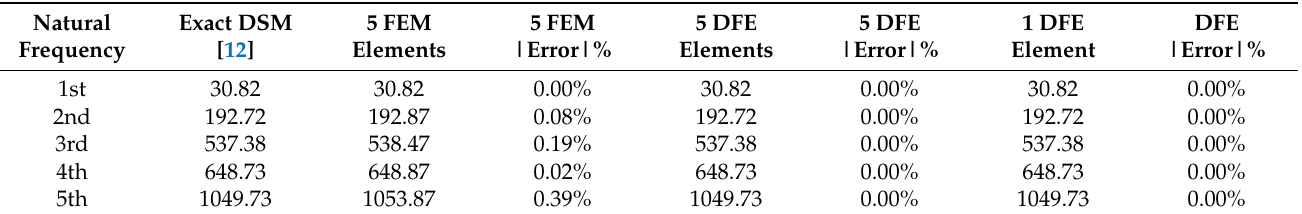
Table 1. Comparison of the first five FEM and DFE natural frequency (Hz) results for M zz = 0 and P = 0 with the analytical DSM values